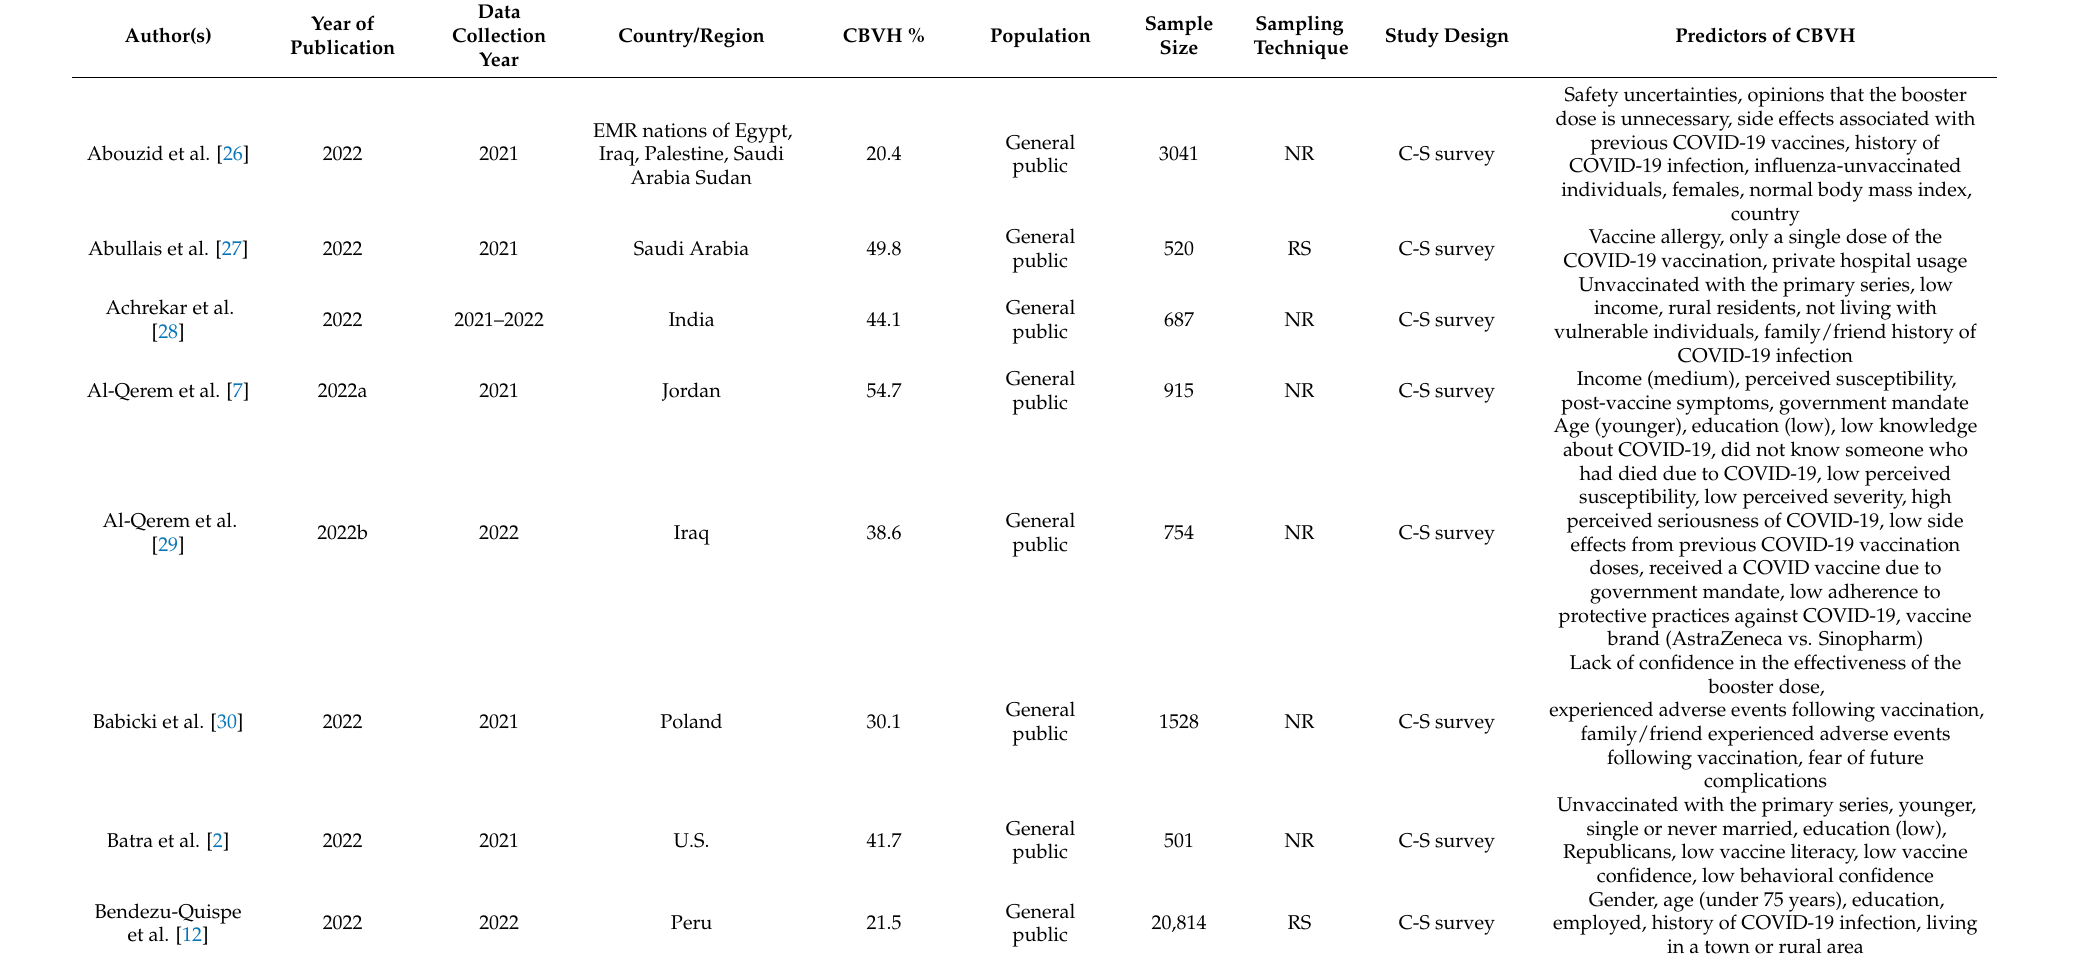
Table 2. Study characteristics and factors influencing COVID-19 booster vaccination